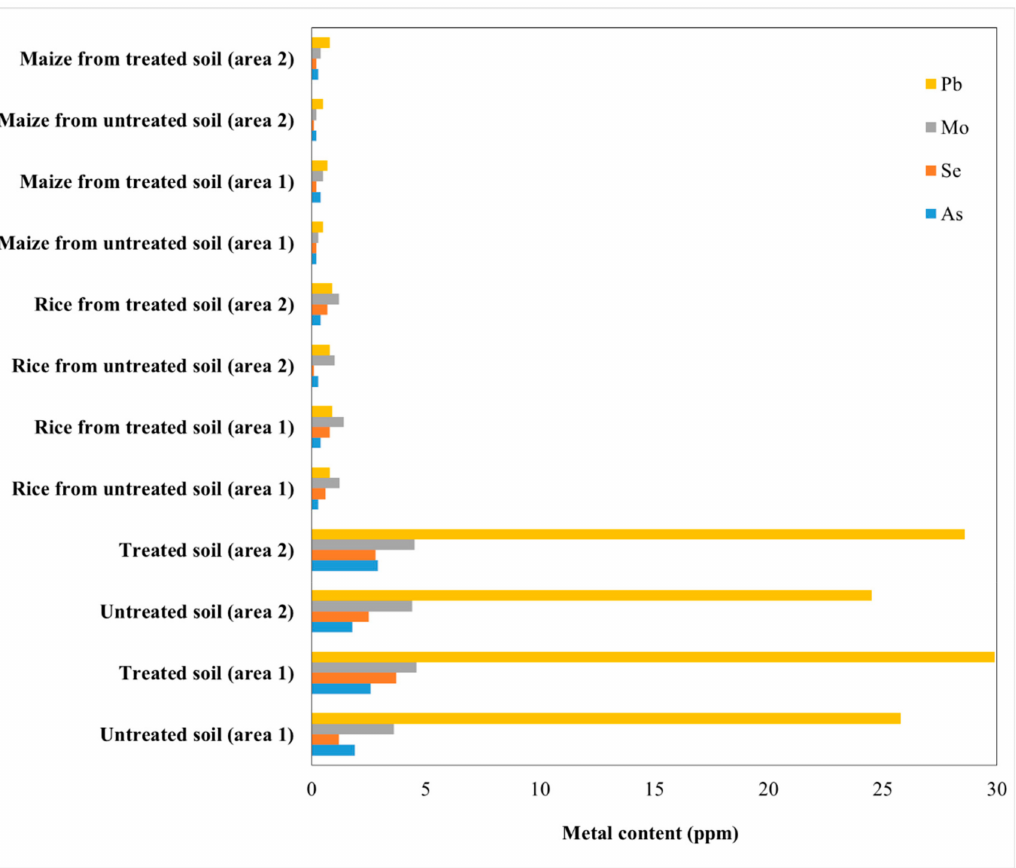
Figure 6. Toxic elements contents in soil, rice and maize from two areas, treated and untreated with fly ash.